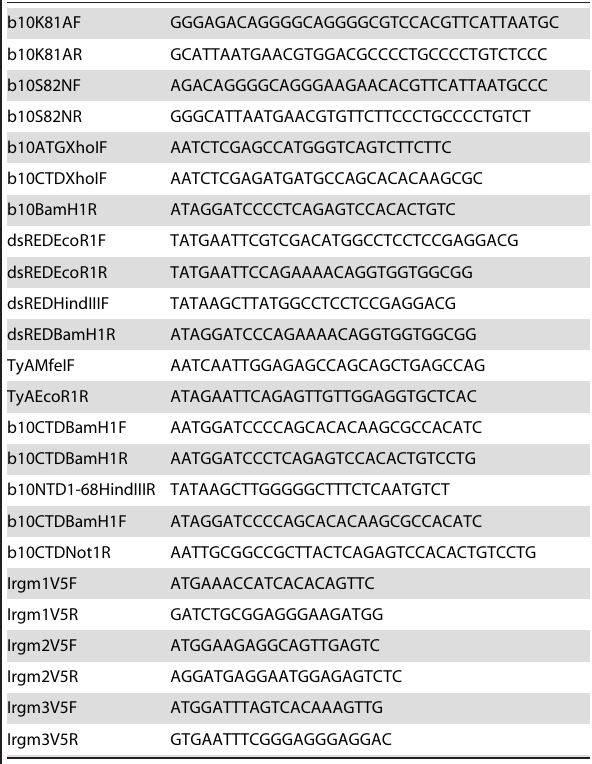
Irgm3 abolished the droplet-like staining pattern of Irga6 in both Irgm3 2 / 2 and Irgm1/m3 2 / 2 MEFs. (TIF) Figure S4 Irgb10 protein is enriched on IRGM-deficient LDs in macrophages. Primary bone marrow-derived maro- phages of the indicated genotypes were stained with BODIPY and anti-Irgb10 after overnight treatment with OA and IFN c . Quantitative analyses of Irgb10 co-localization with LDs were performed using MBF-ImageJ software as described in Materials and Methods. Data are the representative of three independent experiments. Statistical significance of group values relative to wildtype and between marked groups is shown (***, p , 0.005). Representative images are shown. (TIF) Figure S5 GKS proteins mislocalize to endogenous LDs and peroxisomes in Irgm1/m3 2 / 2 . ( A ) Irgb10 localizes to LD in the absence of OA in Irgm1/m3 2 / 2 MEFs. We observed additional aggregate-like, Irgb10-positive structures that did not stain with BODIPY. ( B ) A subset of these structures stained positive with MitoTracker Red. ( C ) Similar to rabbit anti-Irgb10, mouse anti-Irga6 antibody stained aggregate-like structures in Irgm1/m3 2 / 2 but not wildtype cells. Whereas some of these structures stained positive for BODIPY (data not shown), a subset of these structures were decorated with peroxisome marker Pmp70 stained with rabbit anti-Pmp70. ( D ) A subset of peroxisomes stained positive for mouse anti-irgm3 in wildtype cells. (TIF) Figure S6 Irgb10 protein is absent from LDs in Atg5 2 / 2 MEFs. Atg5 2 / 2 MEFs incubated with and without OA and IFN c were stained for Irgb10 and LDs (BODIPY). (TIF) Figure S7 An Irgb10 mutant (S82N) deficient for GTP binding fails to localize to LDs. Irgm1/m3 2 / 2 MEFs were transfected with ( A ) Irgb10WT or ( B ) Irgb10 S82N fused to GFP. Cells were treated overnight with OA and IFN c and stained for the LD resident protein Tip47 and DNA (Hoechst). White arrows point at inclusions. Wildtype Irgb10 but not Irgb10 S82N targets both inclusion and IRGM-deficient LDs. Representative images are shown. (TIF) Figure S8 GBP proteins are enriched on IRGM-deficient LDs. MEFs of the indicated genotypes were treated overnight with OA and IFN c . Cells were stained for endogenous Gbp2, LDs (BODIPY) and DNA (Hoechst). Representative images are shown. Colocalization analyses of Gbp2 with LDs were done using MBF ImageJ software as described in Materials and Methods. (TIF) Figure S9 IFN c activation results in a decrease in LD mass as assessed by BODIPY staining in IRGM- deficient MEFs. Wildtype and Irgm1/m3 2 / 2 MEFs were treated with OA to enrich for total LD mass. Cells were treated with IFN c and stained with BODIPY. Flow cytometry was used to measure the BODIPY signal, which corresponds with LD mass. The fold change in the average mean fluorescent intensity (MFI) in response to IFN c treatment is plotted in the panel on the right. (TIF)